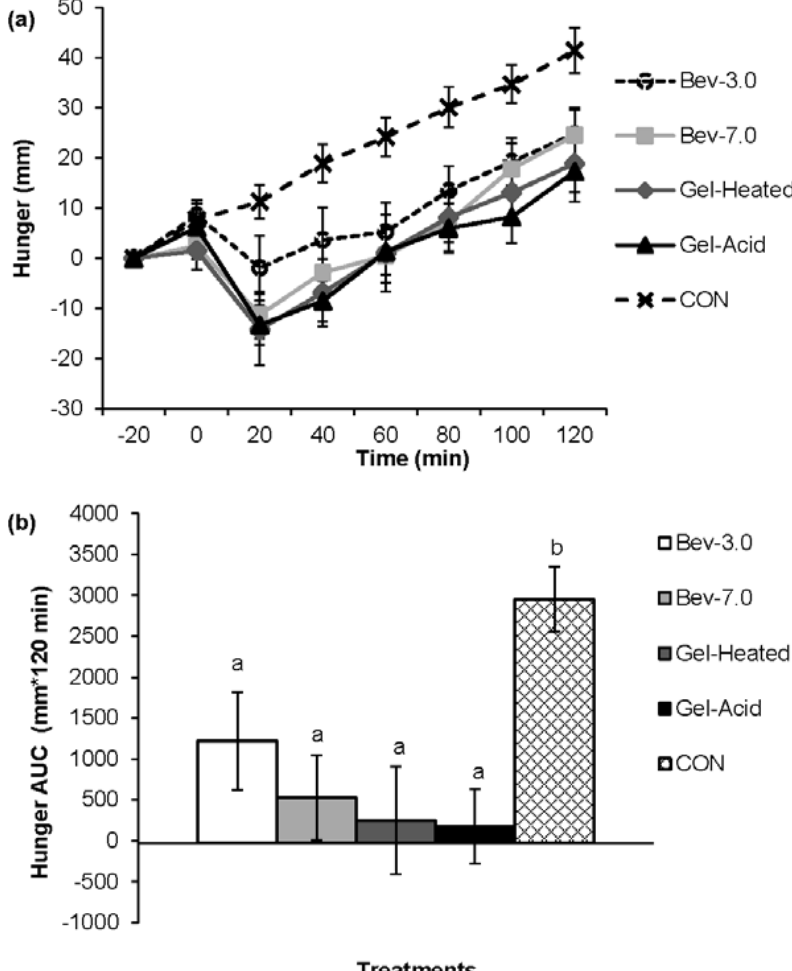
Figure 1. Perceived hunger across time for each treatment ( a , line graph) and the 2-h net incremental area under the curve (AUC) for the different treatments ( b , bar graph). Time 0 is when the snack was consumed. Different letters denote significance ( p < 0.05) between treatments. Snacks: 0 kcal water (CON) or 96 kcal whey protein snacks as beverages with a pH of either 3.0 (Bev-3.0) or 7.0 (Bev-7.0) or gels as acid (Gel-Acid) or heated (Gel-Heated).